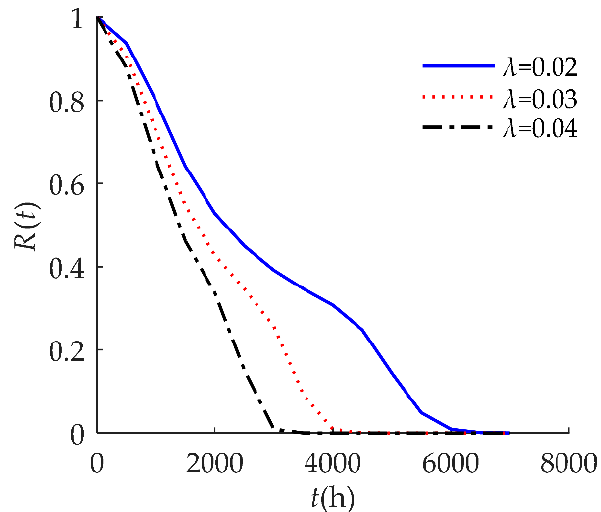
Figure 7. Sensitivity analysis of R ( t ) on λ for example I.